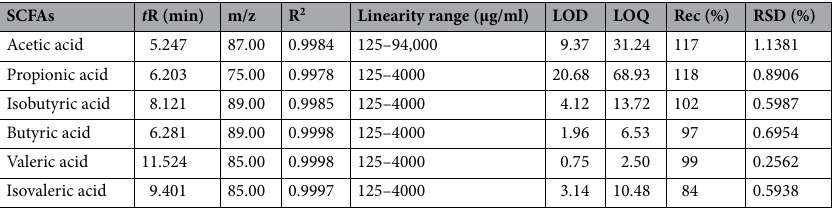
Table 1. Analytical parameters of GC/MS analysis of SCFAs. tR retention time, m/z mass to charge ratio, R 2 coefficient of determination of linear regression, LOD limit of detection, LOQ limit of quantification, Rec recovery rate, RSD relative standard